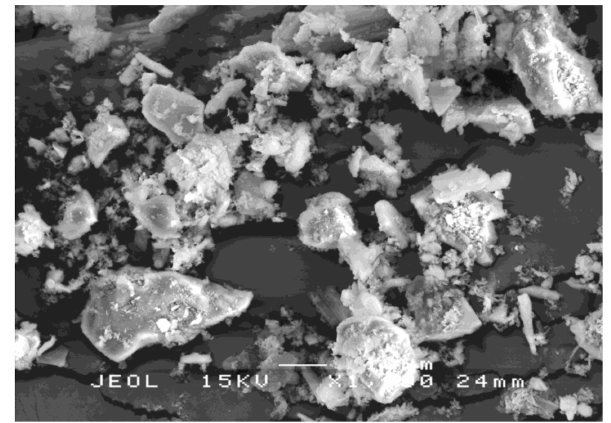
Figure 3. SEM image of the RHA structure after